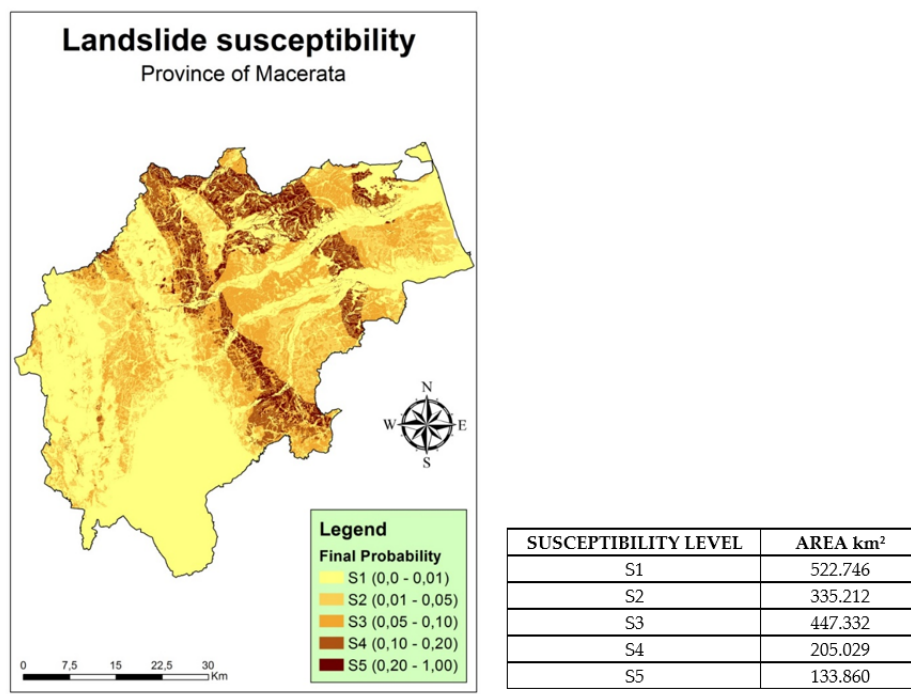
Figure 10. ( Left ) Landslide susceptibility of the Province of Macerata; ( Right ) Area of landslides introduced as a result of the validation procedure, in relation to the landslide susceptibility level predicted by the model of this study.